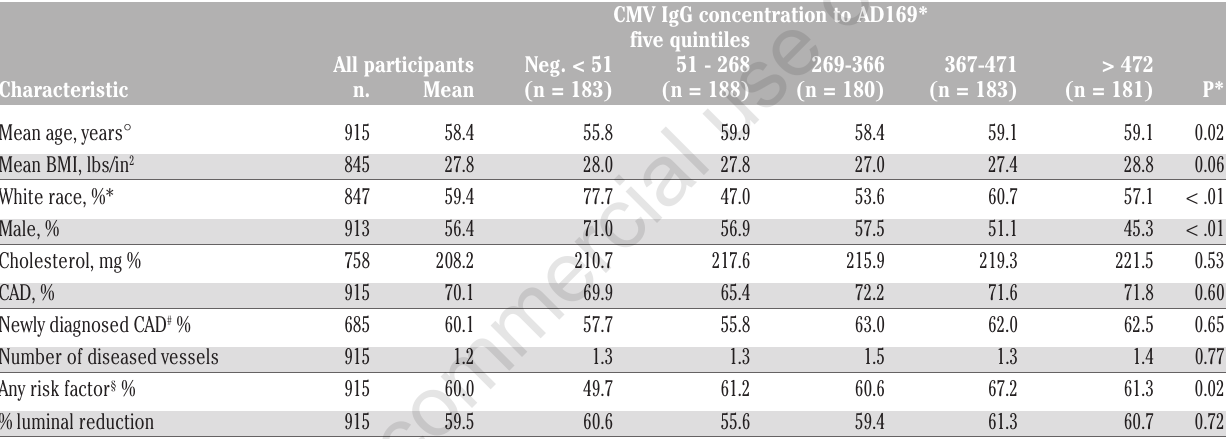
Table 1. Baseline characteristics of the study patients by cytomegalovirus IgG concentration quintiles using AD169 antigen.